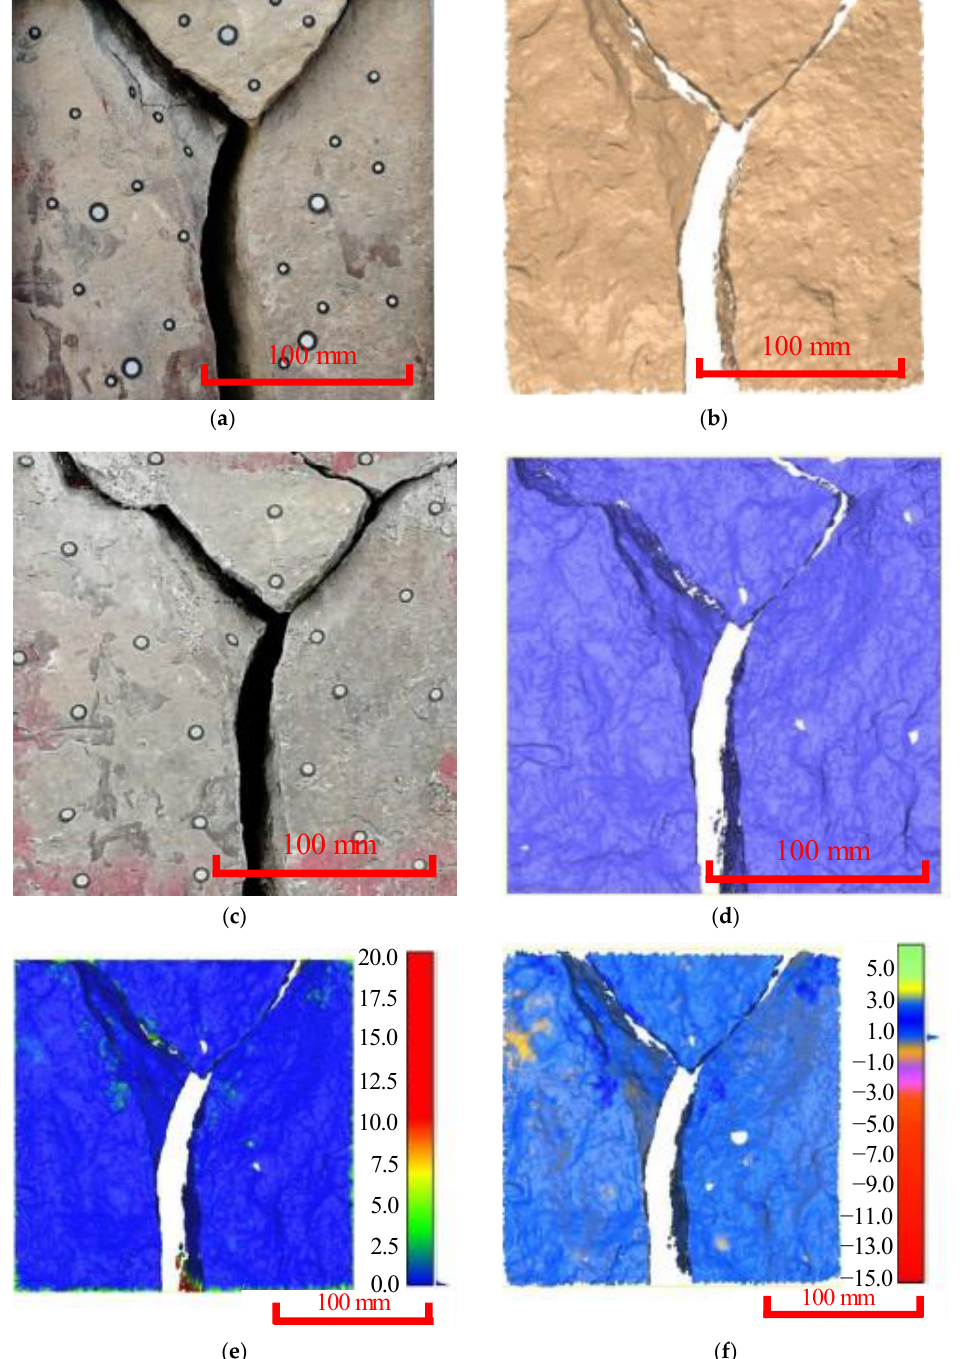
Figure 3. In situ and 3D cloud diagram of Y-joint. ( a ) Site picture of the measuring area (Period I). ( b ) Image of the 3D laser scanning (Period I). ( c ) Site picture of the measuring area (Period II). ( d ) Image of the 3D laser scanning (Period II). ( e ) Deformation distribution obtained using the C2C method. ( f ) Deformation distribution obtained using the M3C2 method.